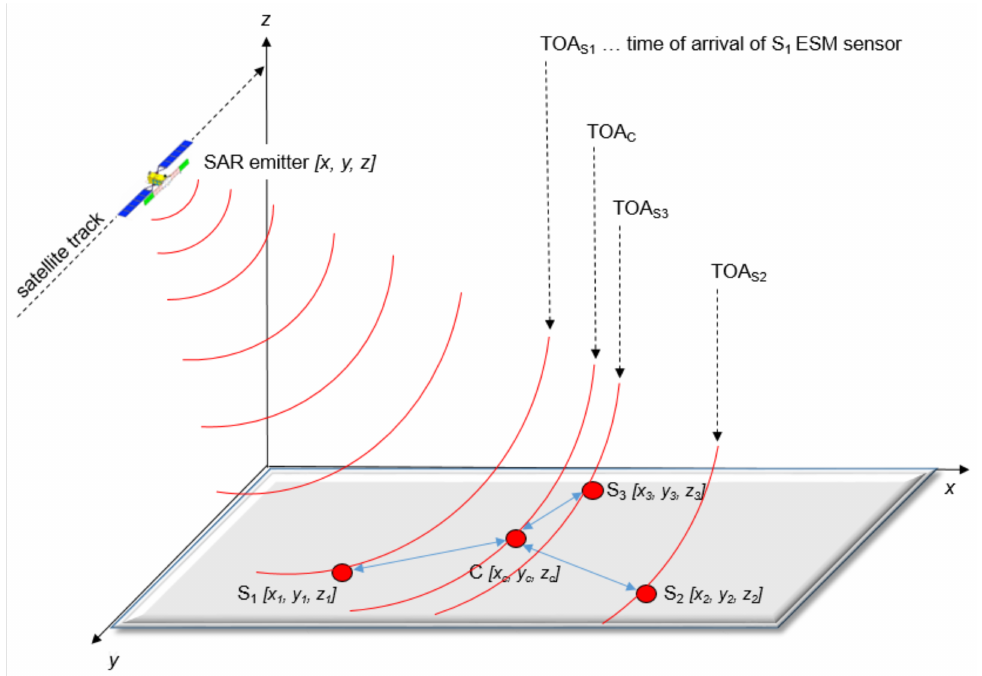
Figure 4. ESM sensors (S 1 , C, S 3 , S 2 ) are irradiated by the SAR emitter and measure the time of arrival of the advancing signal from the SAR emitter. In practice, sidelobes of SAR emitter can be used, see